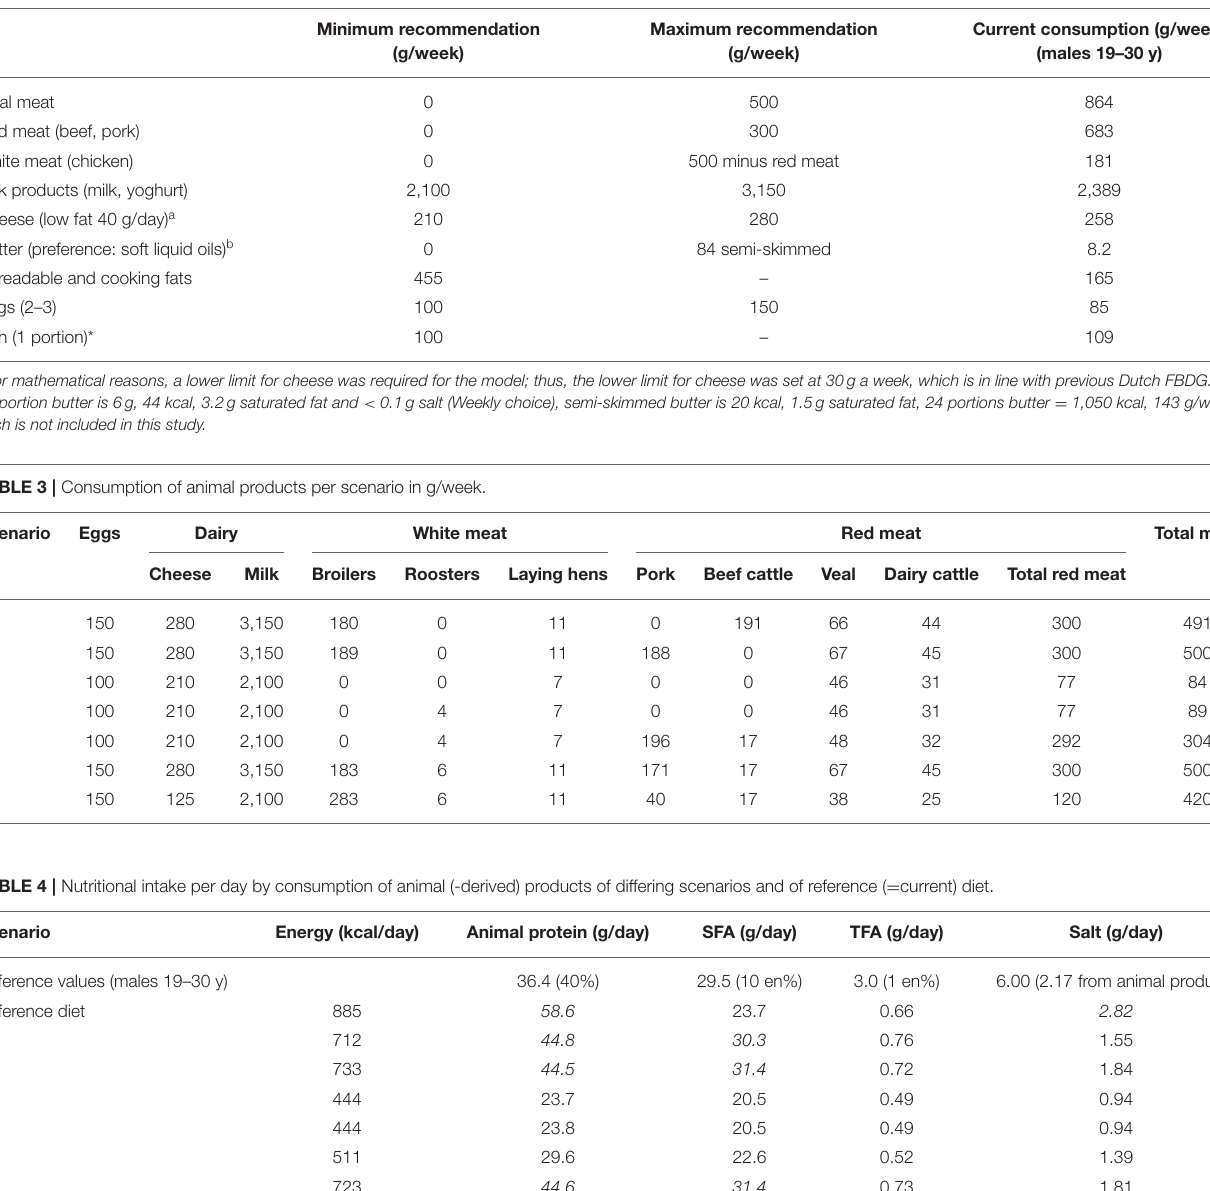
Table 4 ), but lower in all minimum scenarios (i.e., lower